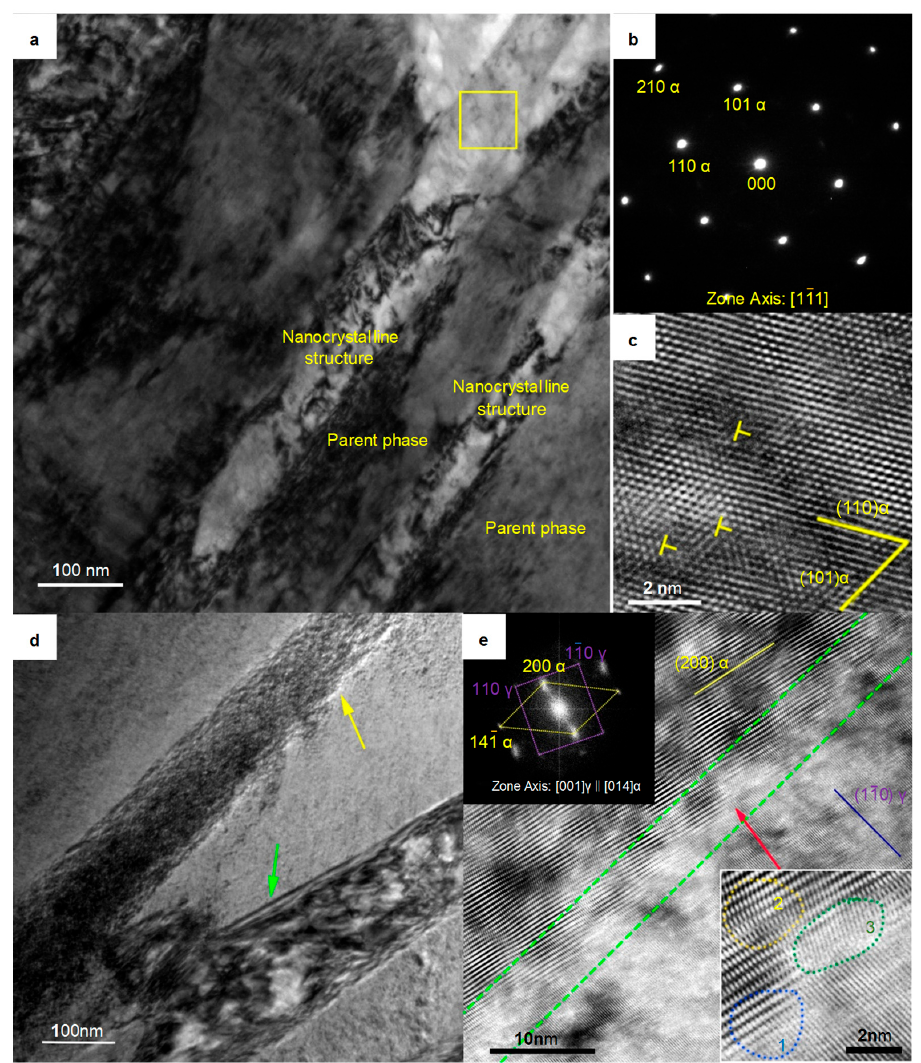
Figure 5. TEM micrographs of the sample austempered at 280 °C. ( a ) Bright-field image of the parent phase and the nanocrystal phase; ( b ) Electron diffraction pattern of the area indicated by the yellow frame in ( a ). ( c ) High resolution transmission electron microscope (HRTEM) image of the area located in the yellow frame in ( a ); ( d ) Bright-field image of the boundary between the nanoplate and the parent phase; ( e ) HRTEM image of the area indicated by the yellow arrow in ( d ). The image at top left is the fast Fourier transform (FFT) of this image. The image at the bottom right shows an enlarged view of the area indicated by the red arrow.